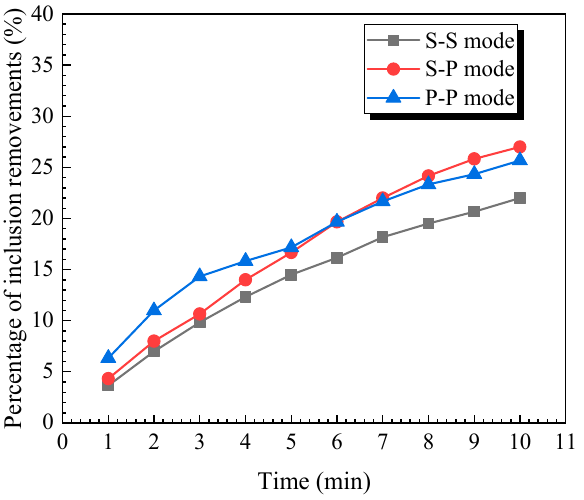
Figure 15. The Comparison of inclusion removements of bottom ‐ stirring with different plugs.